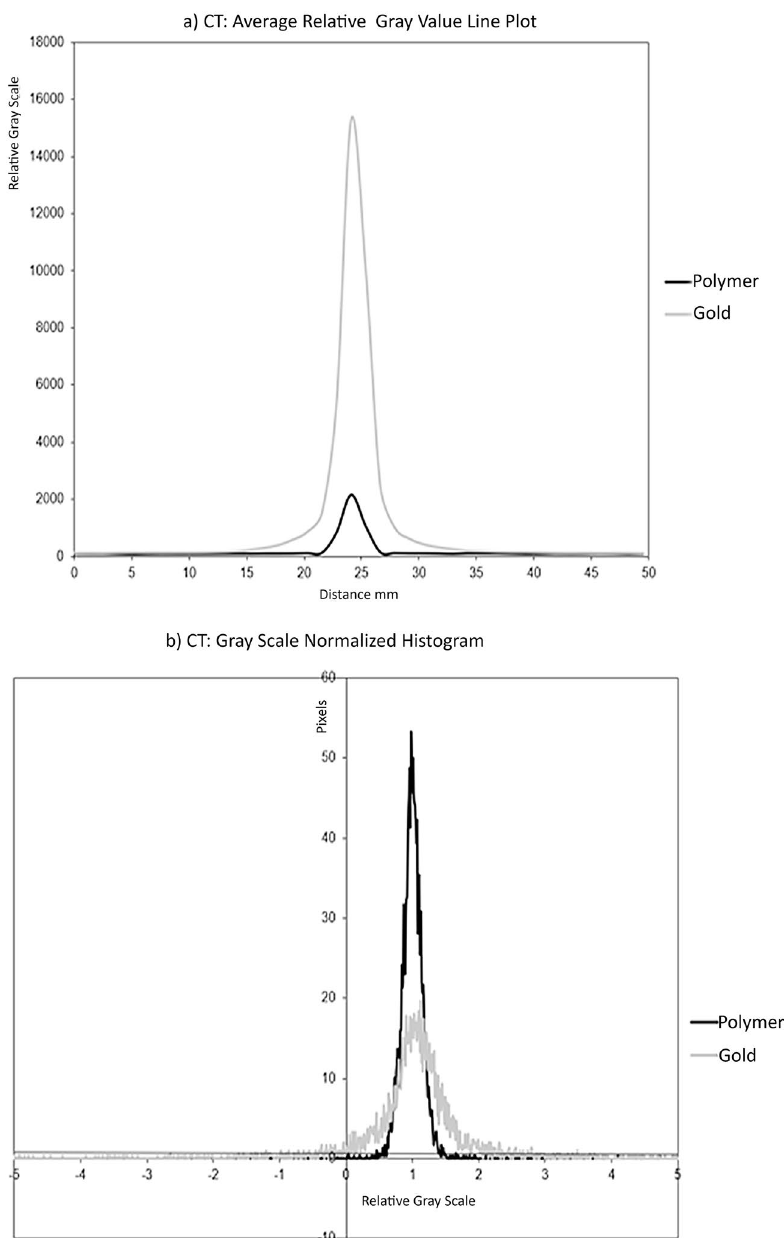
Figure 3. ( a ) line profile of average relative pixel gray values along a 50 mm horizontal line centered on each fiducial marker on CT, ( b ) CT histogram of average relative pixel gray values within a 50 × 50 mm square placed centered on each fiducial marker on CT, polymer and